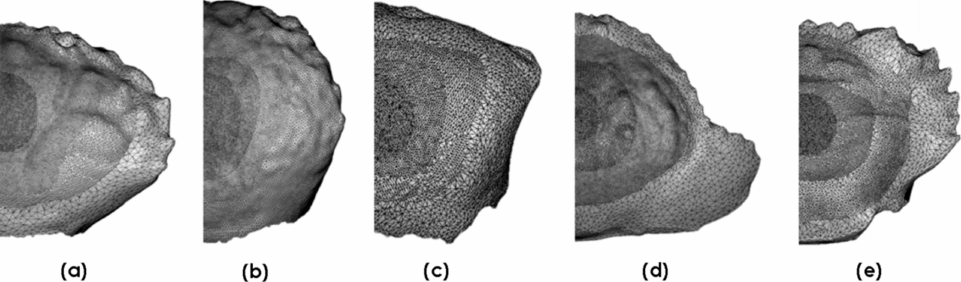
Figure 4. Orphan meshes for each of the five crab species: ( a ) L. sanguineus ; ( b ) P. vespertilio ; ( c ) U. tetragonon ; ( d ) C. hepatica ; ( e ) T. danae